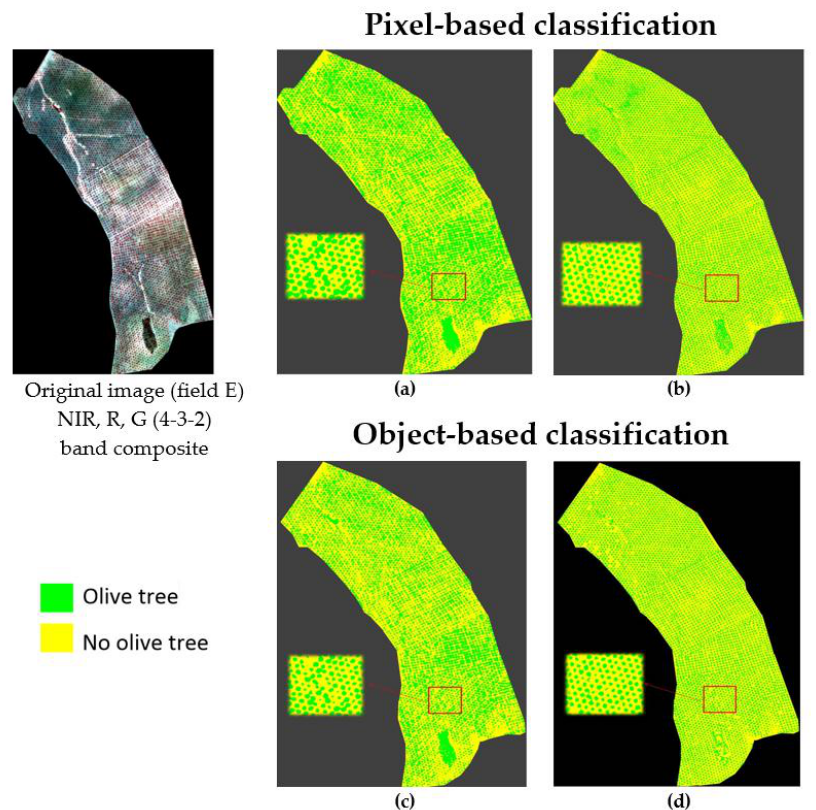
Figure 3. Result of the least ( a , c ) and most accurate ( b , d ) olive orchard classifications of field E.